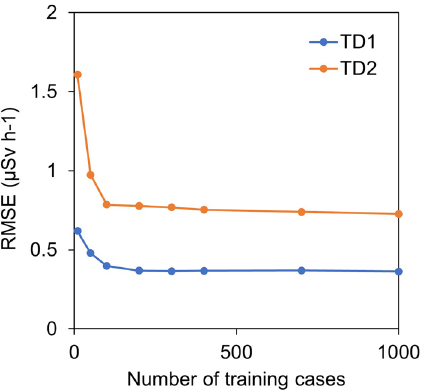
Figure 6. Relationship between the number of training cases and the error. This is the RMSE of the ground- based survey value and the ANN conversion values when the number of training cases increases in a random training network. TD1 and TD2 were constructed with the dataset shown in Table 2.